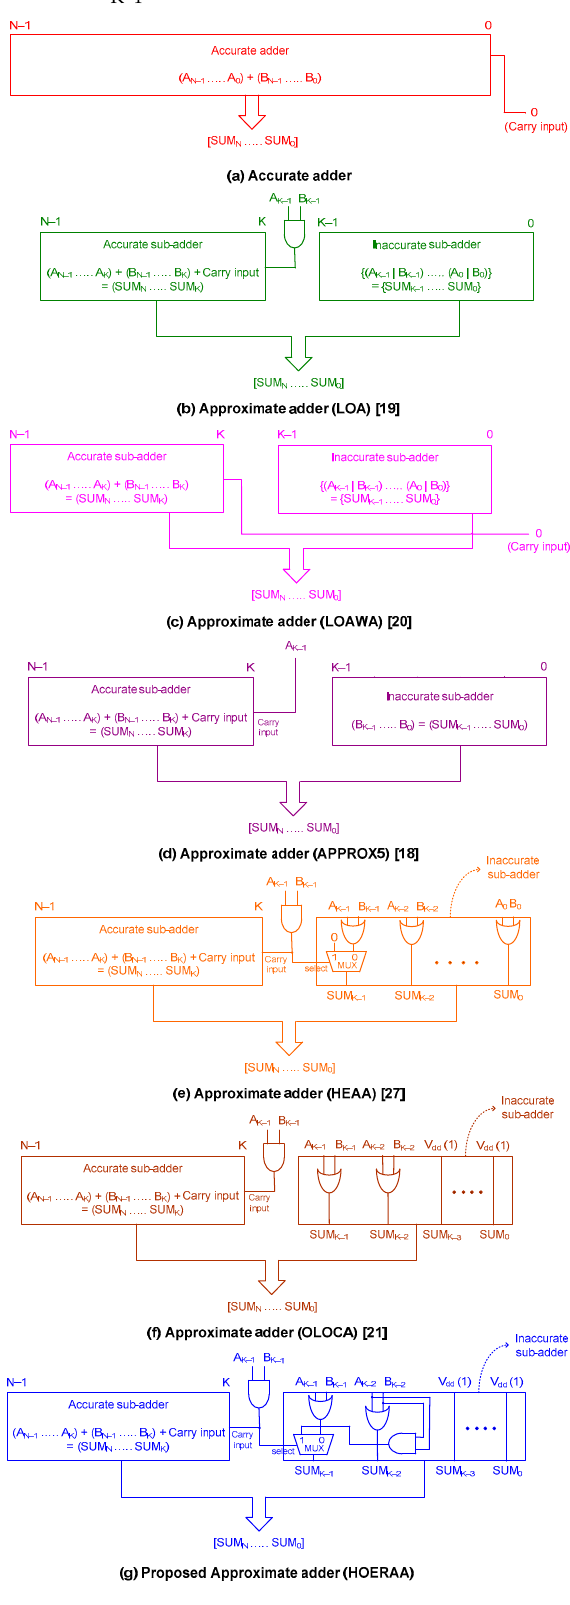
Figure 1. Block schematics of N-bit accurate and approximate adders.